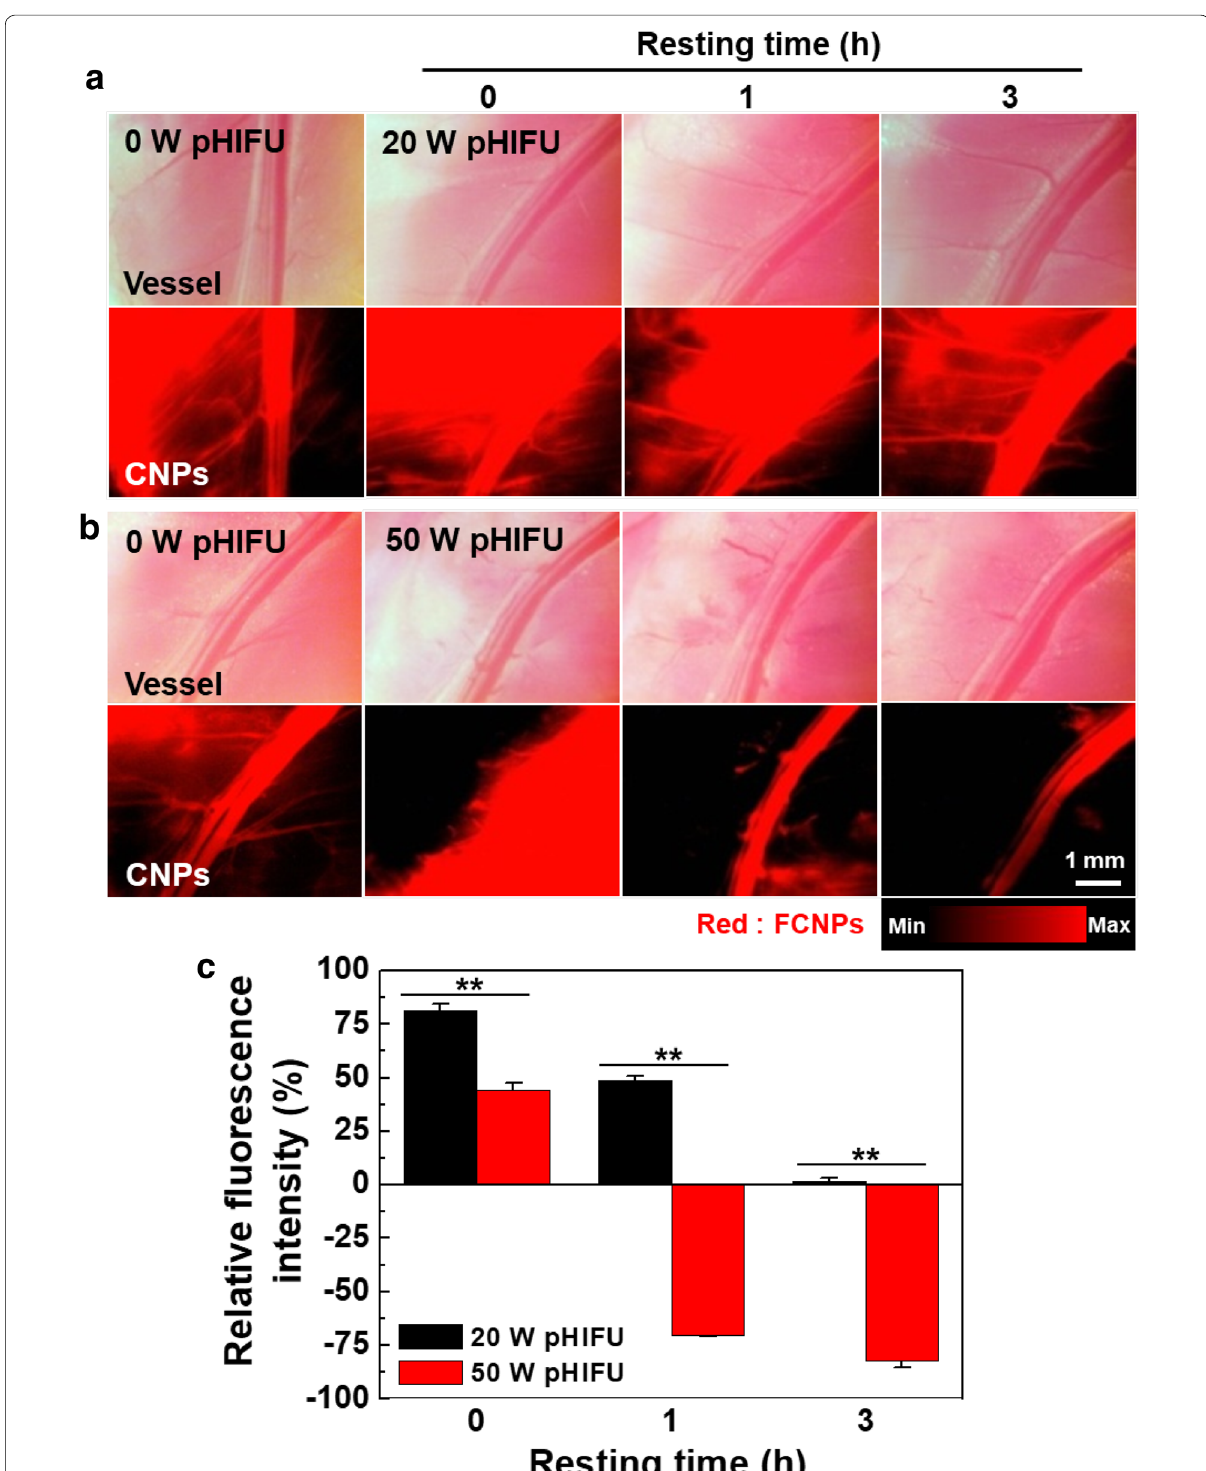
Fig. 5 In vivo tissue penetration recovery analysis in pHIFU-treated femoral tissue. a, b Fluorescence images of femoral tissues, which rested for 0, 1, and 3 h after treatment of 0, 20, and 50 W pHIFU. The fluorescence signal was monitored at 30 min after intravenously injecting of FCNPs. Scale bar indicates 1 mm. c Relative fluorescence intensity of FCNPs in femoral tissues. ** indicates difference at the p < 0.001 significance